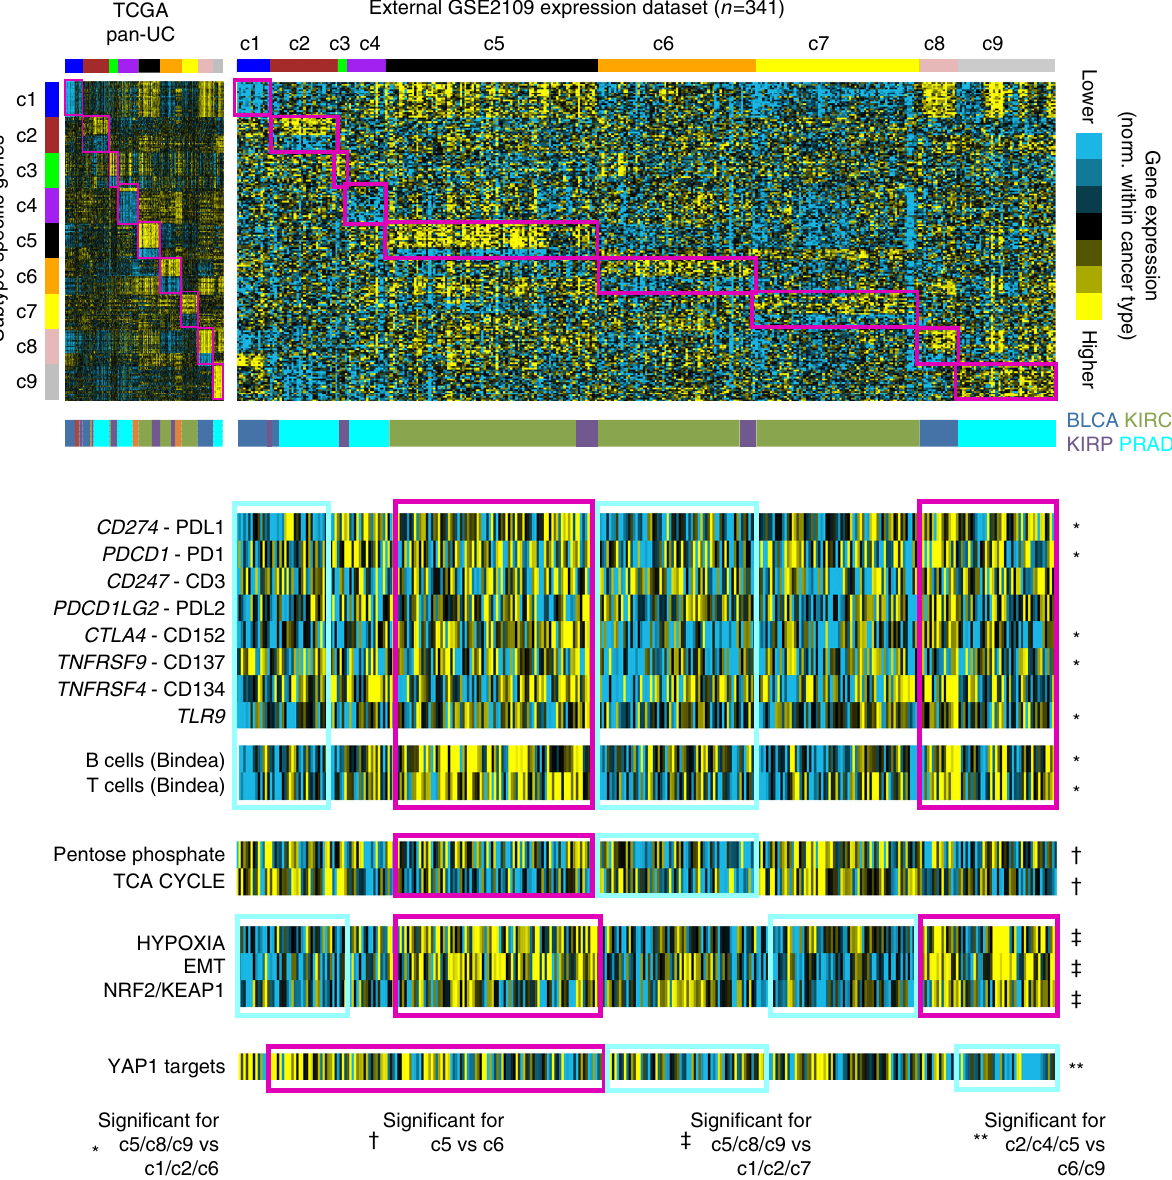
Fig. 7 Observation of patterns associated with TCGA pan-urologic genomic subtypes in an external multi-cancer expression pro fi ling data set. a Gene expression pro fi les of 341 urologic cancer cases (bladder, prostate, clear cell renal, papillary renal), represented in the Expression Project for Oncology (expO) (GSE2109) data set, were classi fi ed according to TCGA pan-urologic genomic subtype. Expression patterns for the top set of 900 mRNAs distinguishing between the nine COCA-based TCGA genomic subtypes (from Fig. 2b) are shown for both TCGA and GSE2109 data sets. Genes in the GSE2109 sample pro fi les sharing similarity with TCGA pan-urologic subtype-speci fi c signature pattern are highlighted. b In the same manner as carried out for TCGA data sets (Figs. 5 and 6), expO expression pro fi les were scored for gene signatures related to immune cells, metabolism, hypoxia, EMT, NRF2- ARE, and Yap1. As indicated, sample pro fi les highlighted in red were compared with the sample pro fi les highlighted in blue (the comparisons being based on those carried on in Figs. 5 and 6 for TCGA data). P -values by t -test, with P < 0.05 considered as statistically signi fi cant. Parts a and b have the